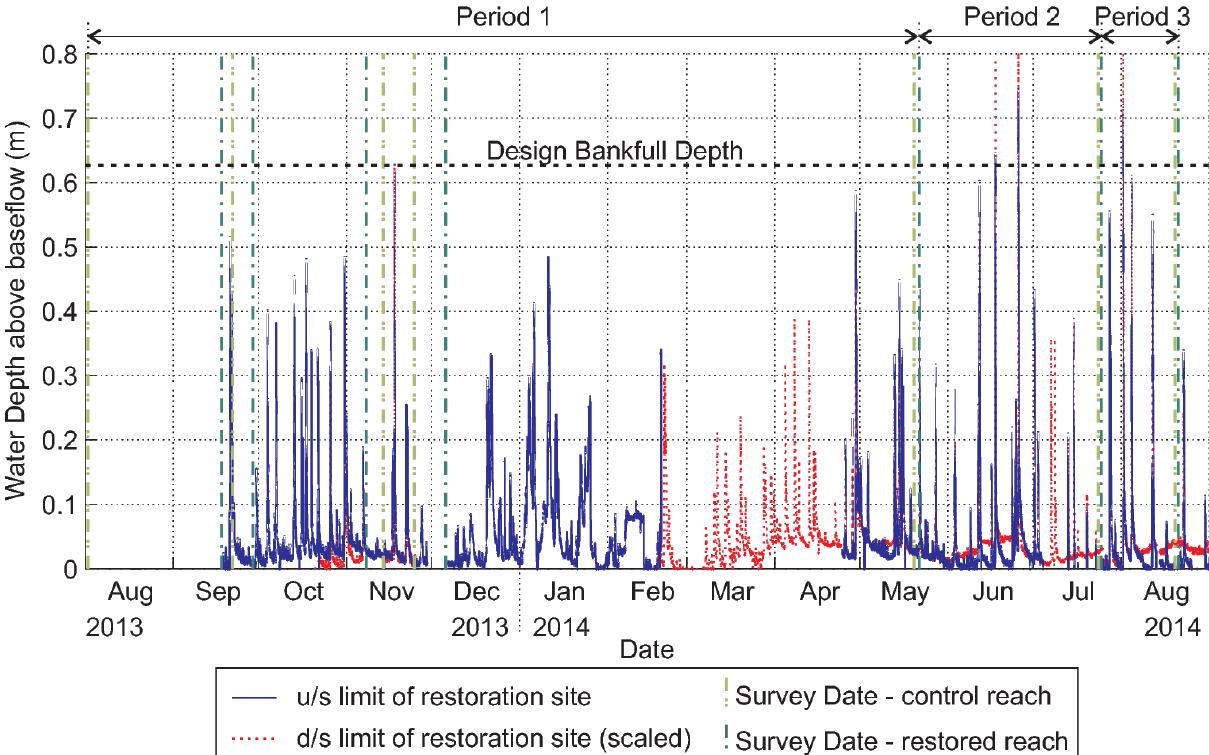
Figure 5. Water surface elevation above baseflow at the upstream limit of the restoration reach. Water surface elevations above baseflow at the downstream limit of the restoration site were scaled to illustrate the degree of flooding in two periods where the upstream gauge was not active. Note that water surface elevations could not be obtained from 1 August 2013 to 18 September 2013 due to an error with the barometric gauge. All survey dates are indicated as are the periods used in the current paper for